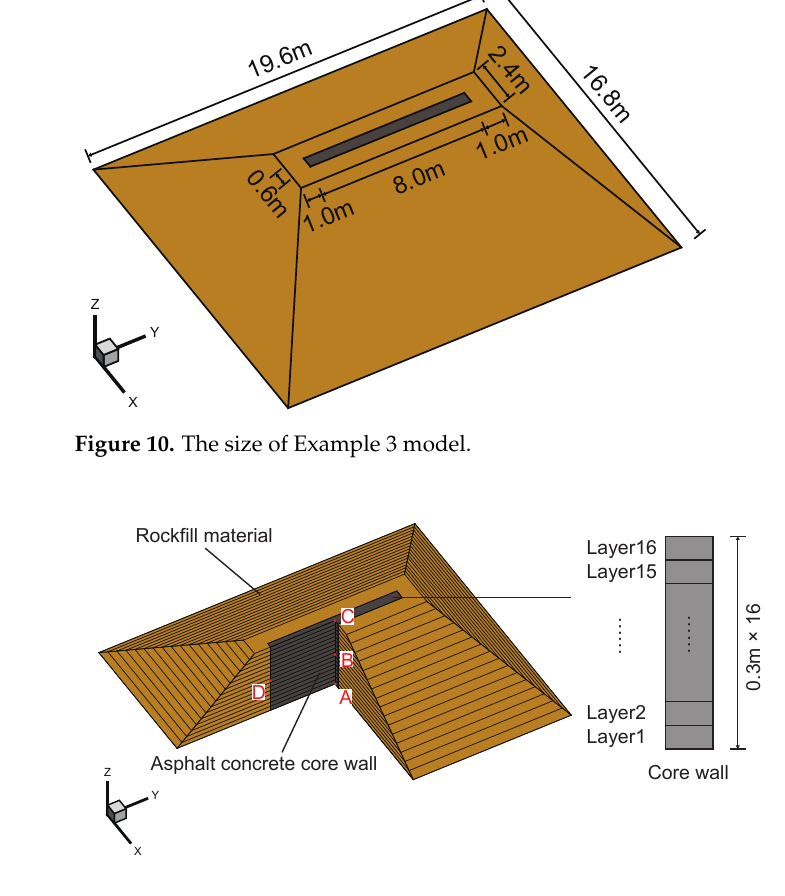
Figure 11. The component of Example 3 model.